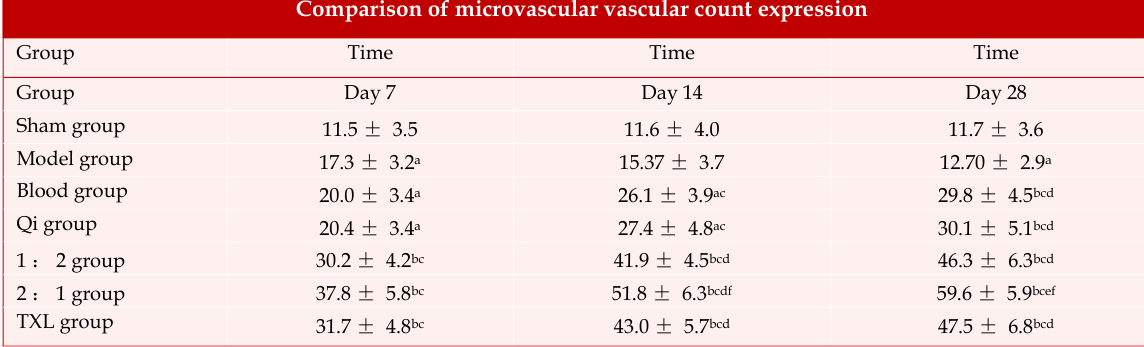
Comparison of microvascular vascular count